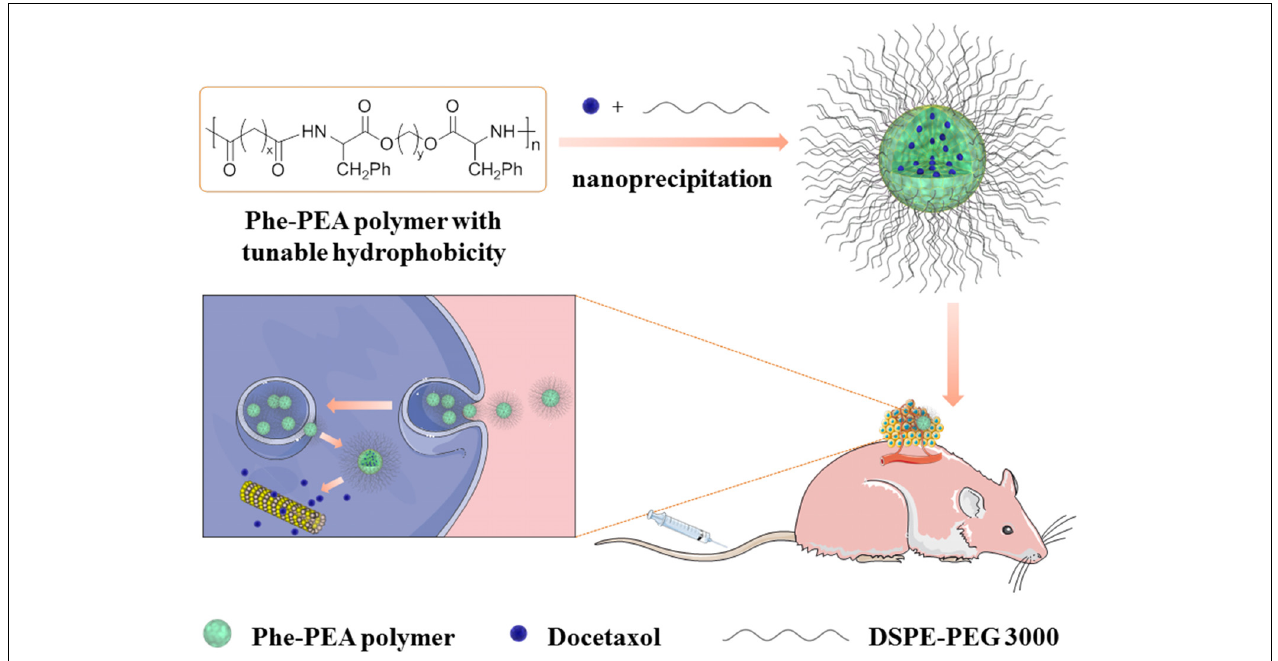
FIGURE 1 | Representative scheme for preparation of Dtxl-8P4 NPs and introduction of in vivo and intracellular delivery.